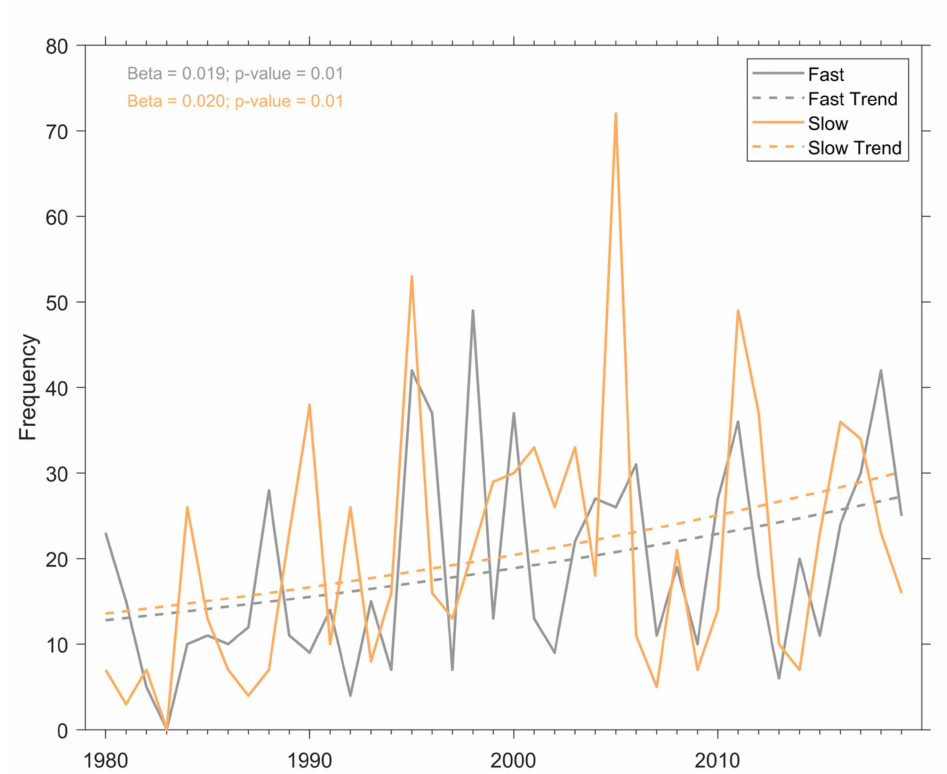
Figure 3. Time series and trend lines of fast (grey) and slow translation (orange) events during 1980–2019.